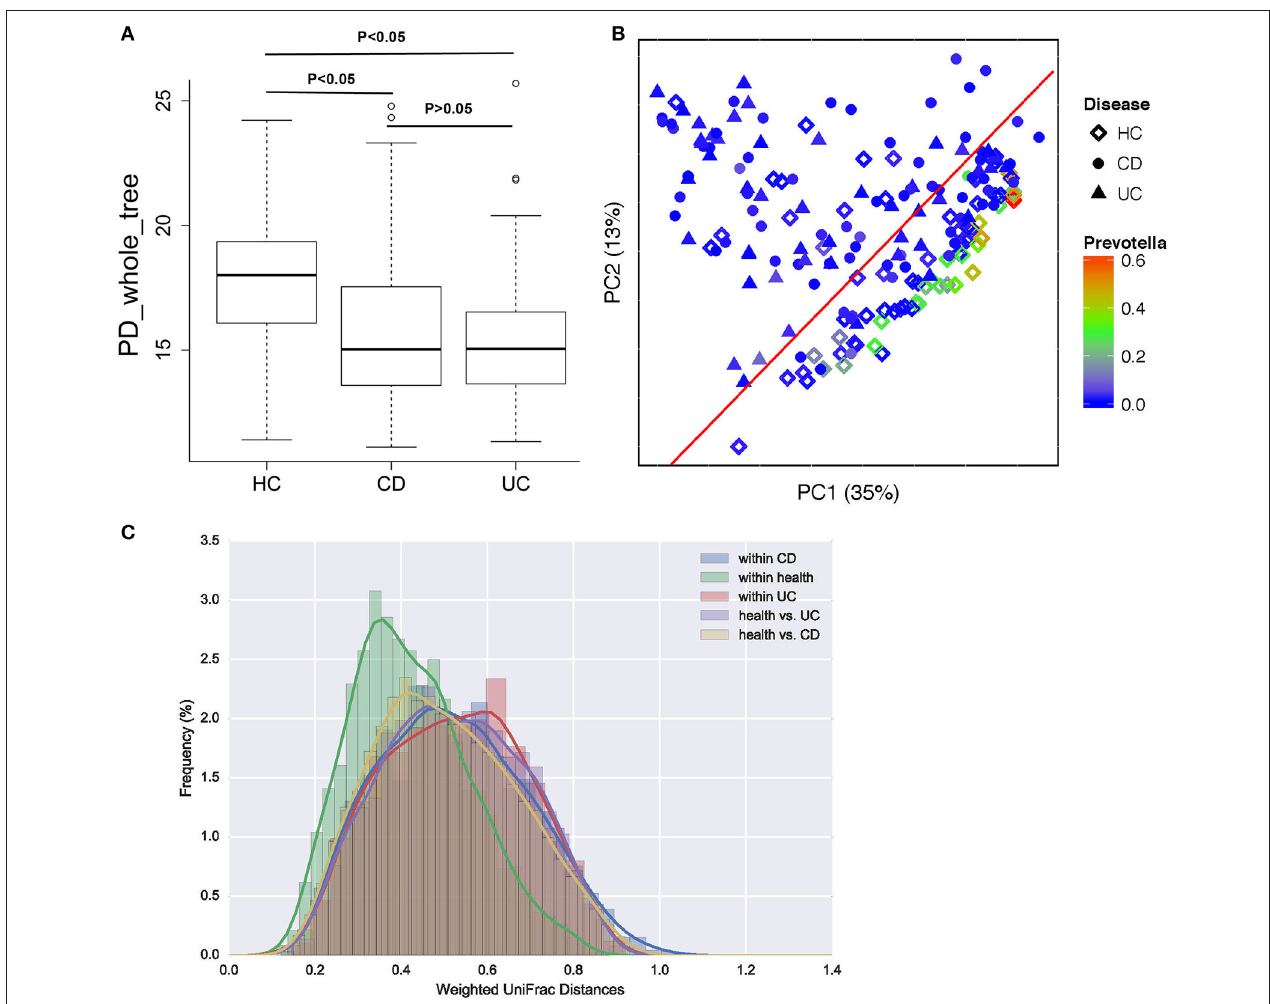
FIGURE 2 | Bacterial diversity in patients with CD or UC and healthy controls (HC). (A) Bacterial α -diversity was measured by the PD whole tree value. (B) Microbial β -diversity shown by principal coordinate plot of the UniFrac distance across UC, CD and HC, with each sample colored by Prevotella , which is more enriched in healthy populations. Each group is defined by a different shape (diamond = HC, circle = CD, triangle = UC). (C) Heterogeneity of gut microbiota in weighted UniFrac distance within diseases and